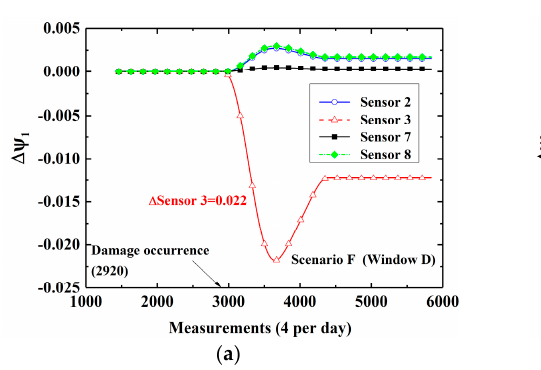
Figure 8. Time-variant CEVs with different space windows for Scenario E: ( a ) Window C; ( b ) Window D; ( c ) Window B; ( d ) Window A.